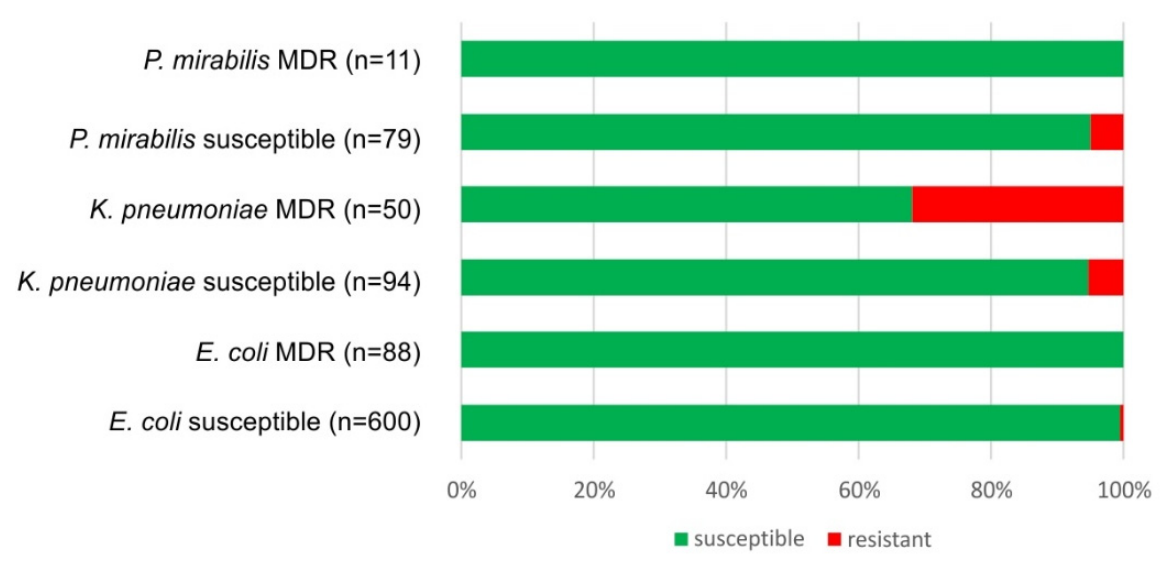
Figure 2. Susceptibility or resistance to nitroxoline among 922 urine isolates of various Enterobacterales (green, susceptible; red, resistant). Table 1. Parallel resistance to cotrimoxazole and third generation cephalosporins or ciprofloxacin, respectively, in MDR E. coli urine